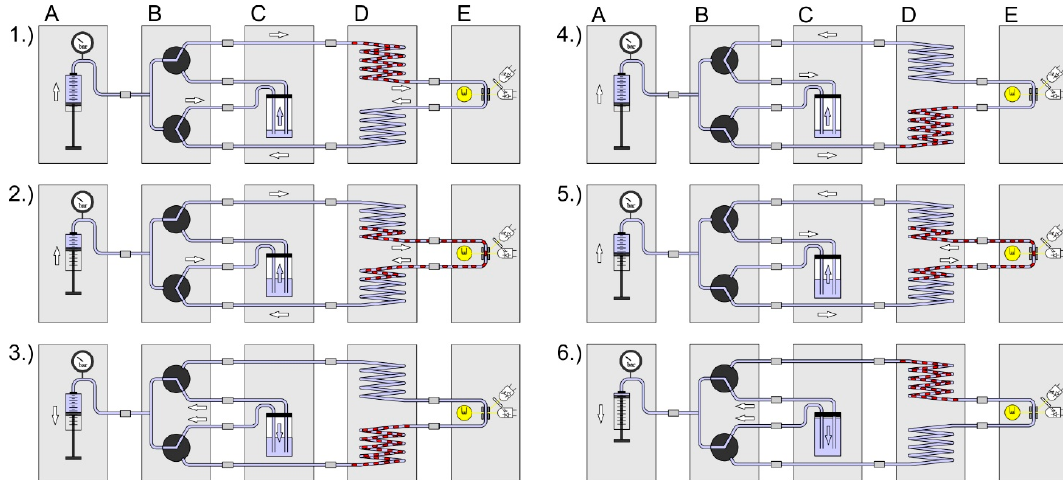
Figure 4. Setup scheme and operational sequence for the iterative measurement of droplet sequences.